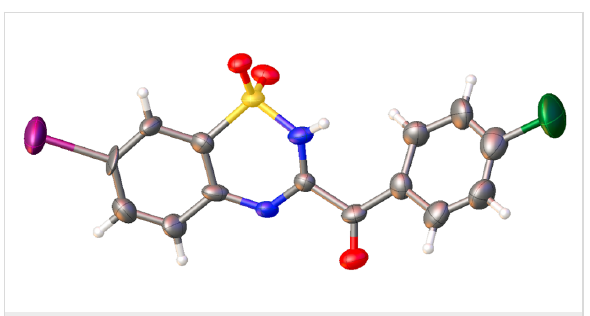
Figure 1: X-ray crystal structure of 4b (CCDC